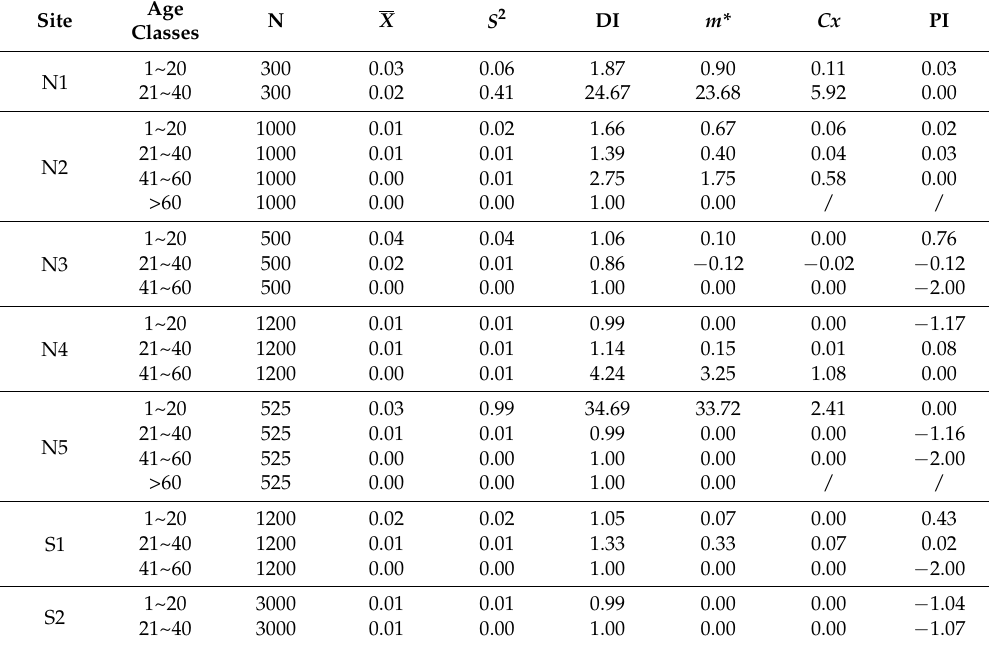
Table 4. Spatial distribution pattern of Larix with different age classes in the seven sampling sites in the alpine treeline ecotone in the eastern Tibetan Plateau over the period of 1971–2014 using the quadrat-based indices, including DI , m* , Cx , and PI . All the indices are statistically significant ( p <